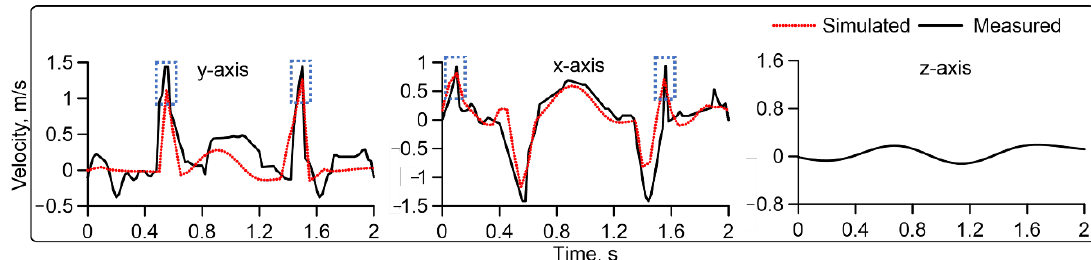
Figure 7. Simulated and measured velocity curves for the gripper in the x- , y- , and z- axis directions for one complete picking cycle. Table 6. Comparison of simulated and measured average velocity of the gripper. Axis